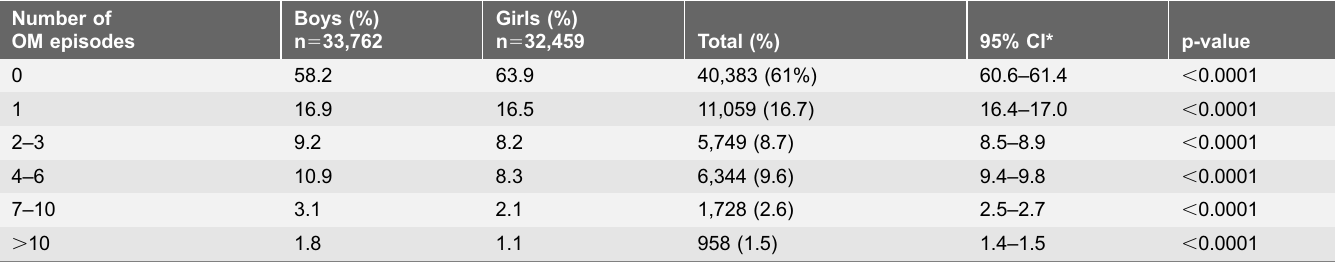
Table 3. Number of episodes of otitis media (OM) at the 18 months’ interview in 32,459 girls and 33,762 boys in The Danish National Birth Cohort, 1996– 2005 Denmark. Number of OM